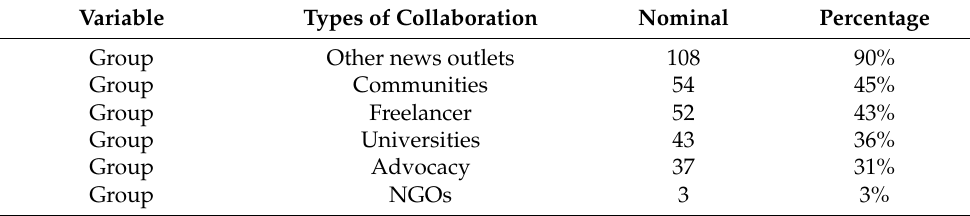
Table 12. Types of